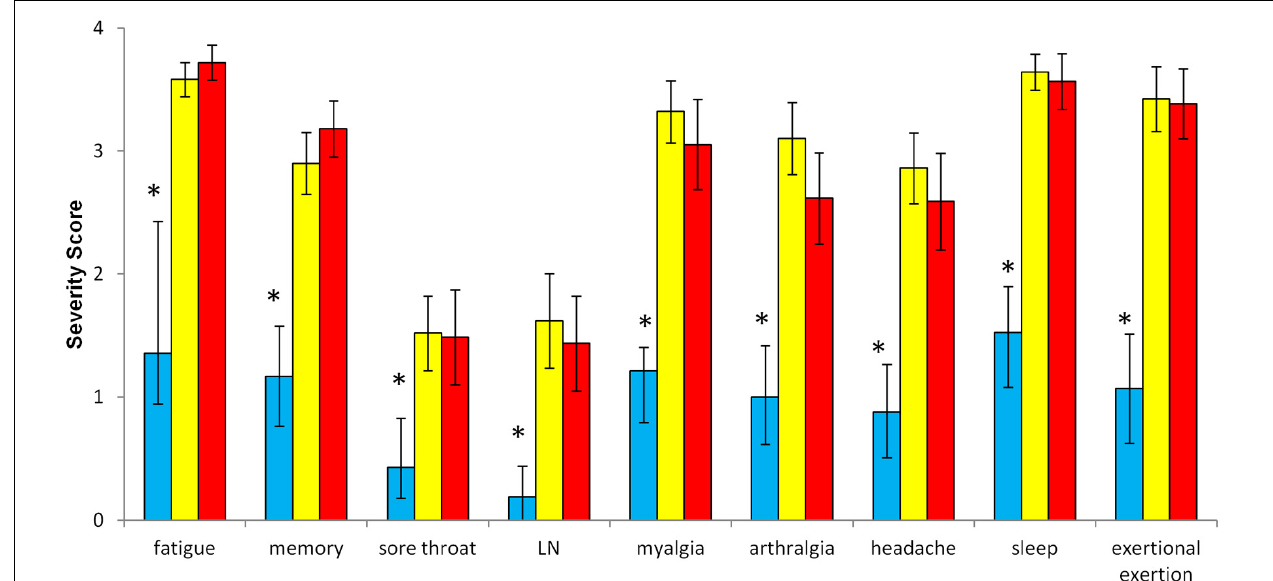
FIGURE 2 | CFS symptom severity scores. The severity of fatigue and the 8 ancillary criteria were scored on an anchored ordinal scales from 0 to 4. Controls (blue columns) had significantly lower scores for each